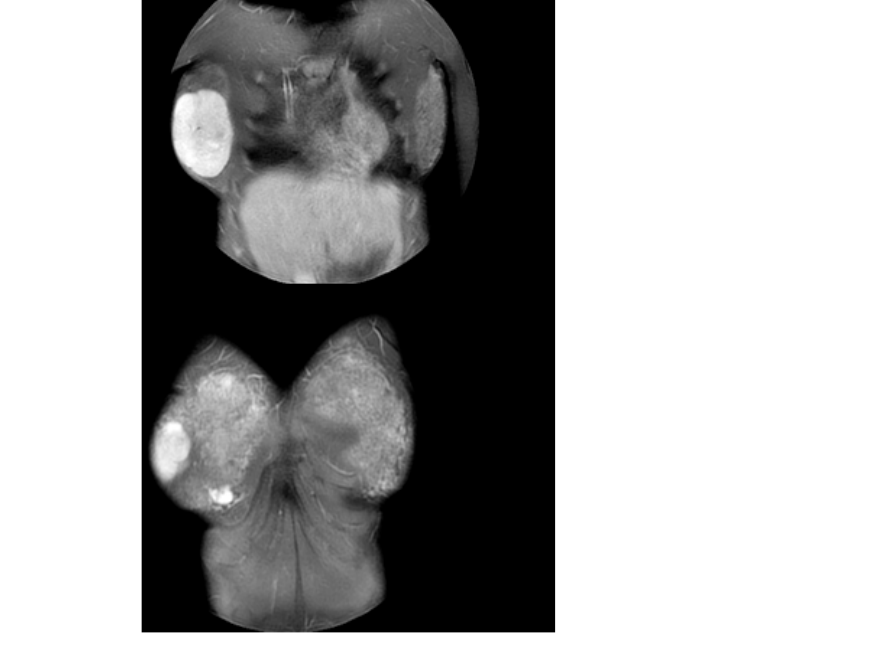
Figure 3. Total surgical excision of the fibroadenoma without reconstructive surgery.